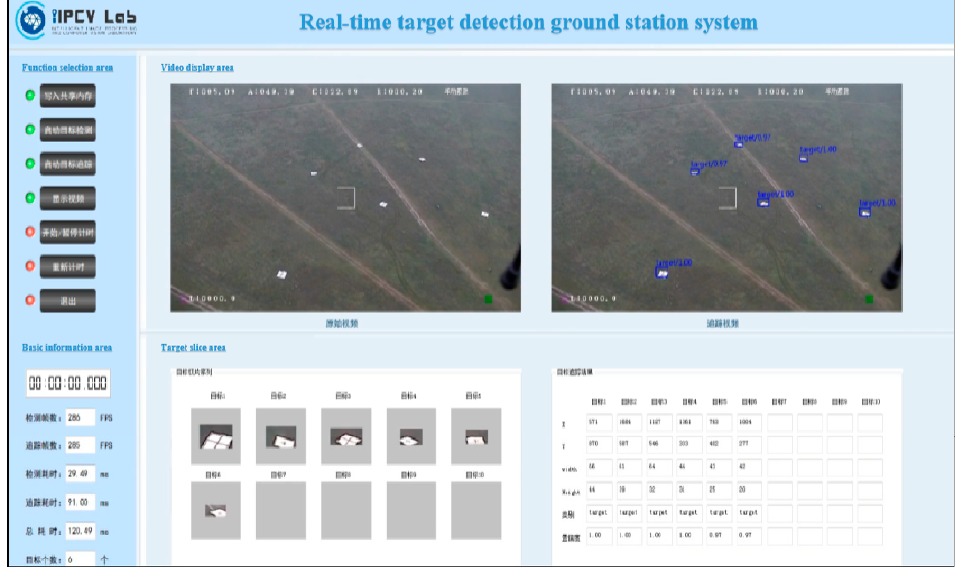
Figure 16. Drone ground station display interface.